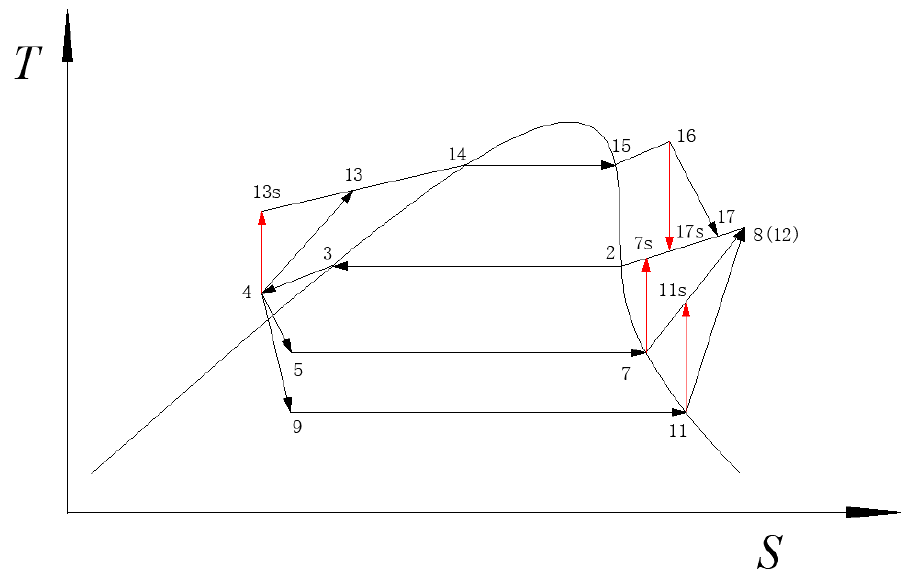
Figure 2. T - s diagram of the ORC-TSVCC system.